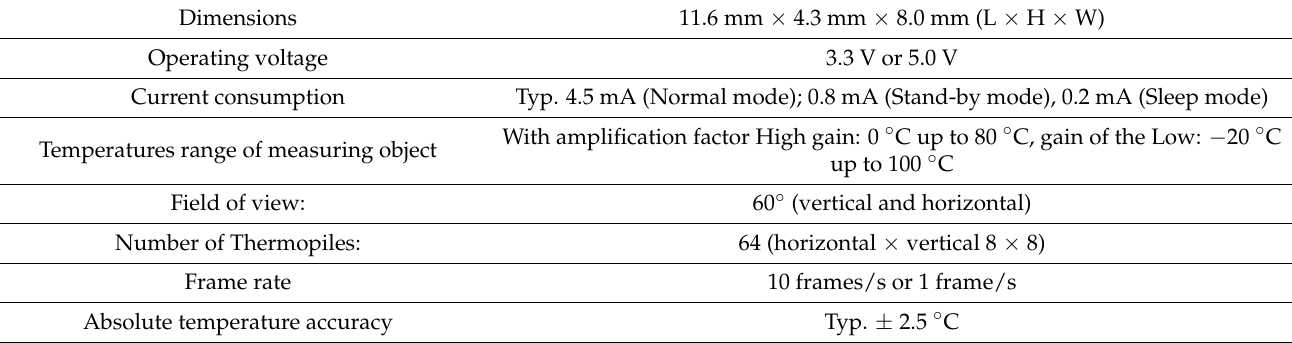
Table 2. Principal features of an IR sensor set-up investigated in this work [25]. Dimensions